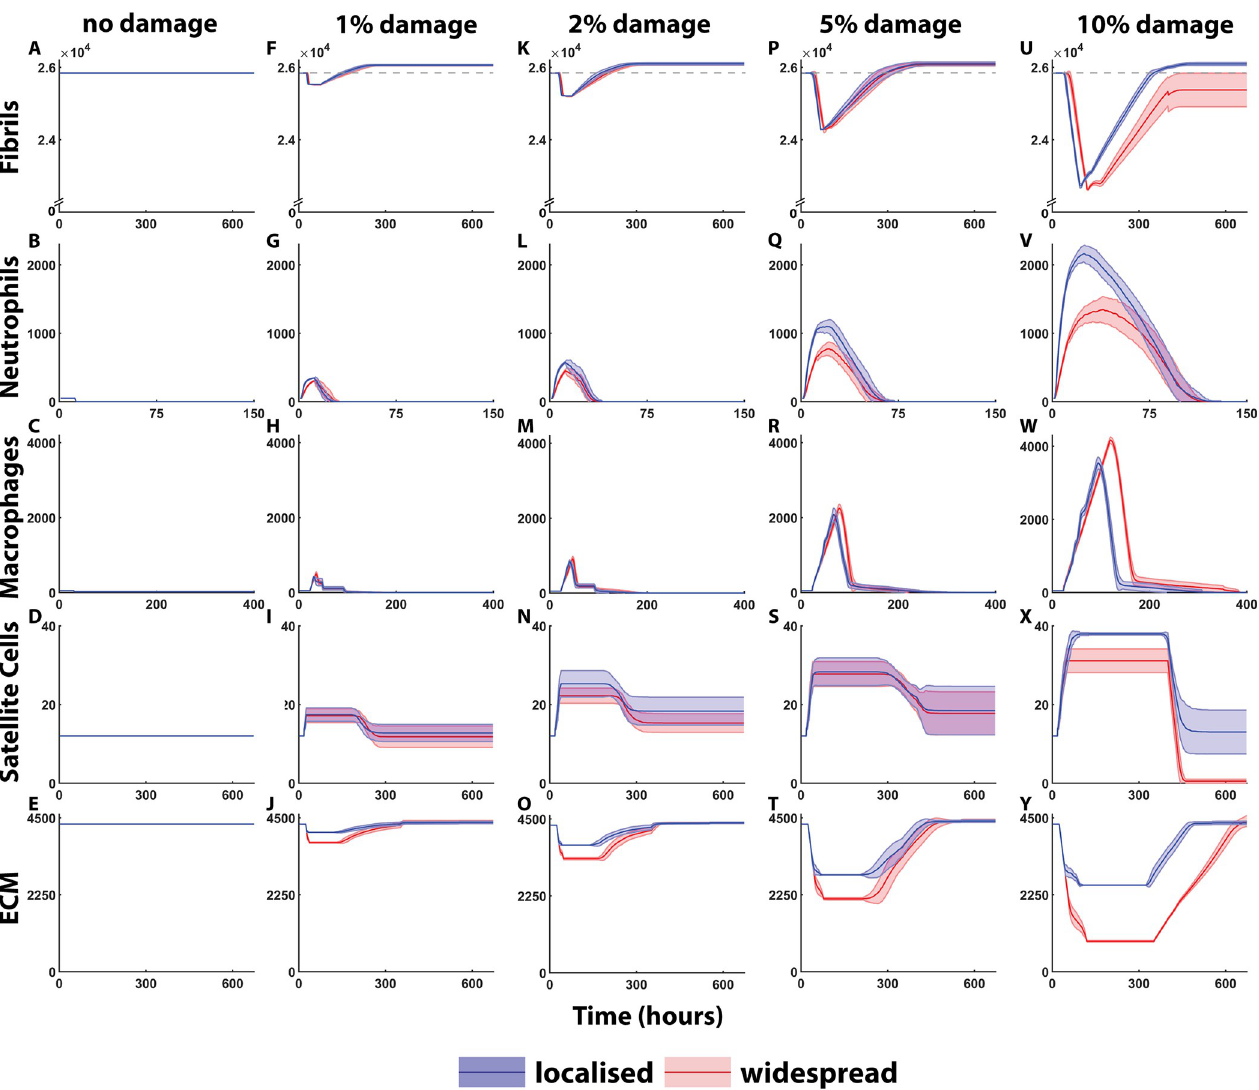
Fig 4. Cell counts (mean ± SD) over 672 h, from 50 simulations in localised and widespread damage conditions. (A-E) are control cell counts where no damage was imposed. (F-J) show fibril, neutrophil, macrophage, SC and ECM counts simulated over 672 h following 1% damage. (K-O) show 2% damage, (P-T) show 5% damage, and (U-Y) show 10% damage. Fibril repair is delayed and does not meet pre-injury levels at 10%. Neutrophils are increased in localised simulations compared to widespread. Macrophage recruitment is delayed and increased in widespread damage simulations. Satellite cell recruitment increases with damage level. The ECM count is recovered under both simulation